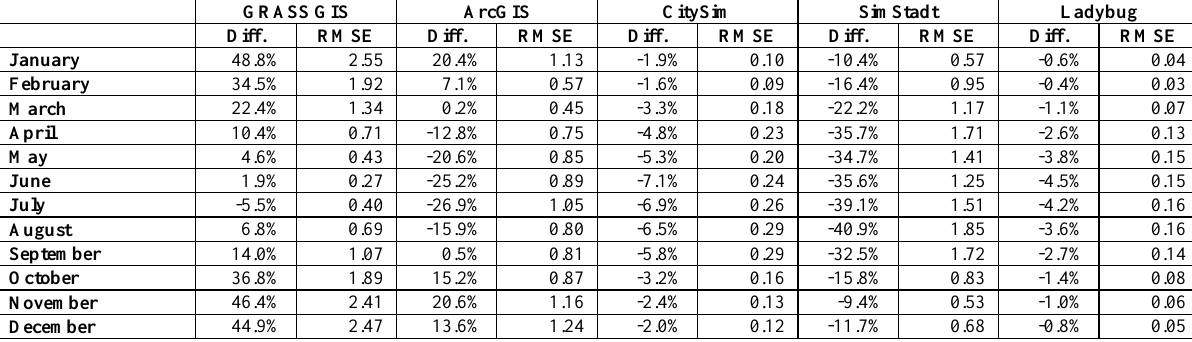
Table 3. Differences and RMSE of simulated monthly solar irradiation values with respect to the INMET weather station. high values of RMSE both on yearly and monthly basis. Somewhere in-between lies ArcGIS, both in terms of yearly and monthly cumulative global solar irradiation values, and corresponding RMSE